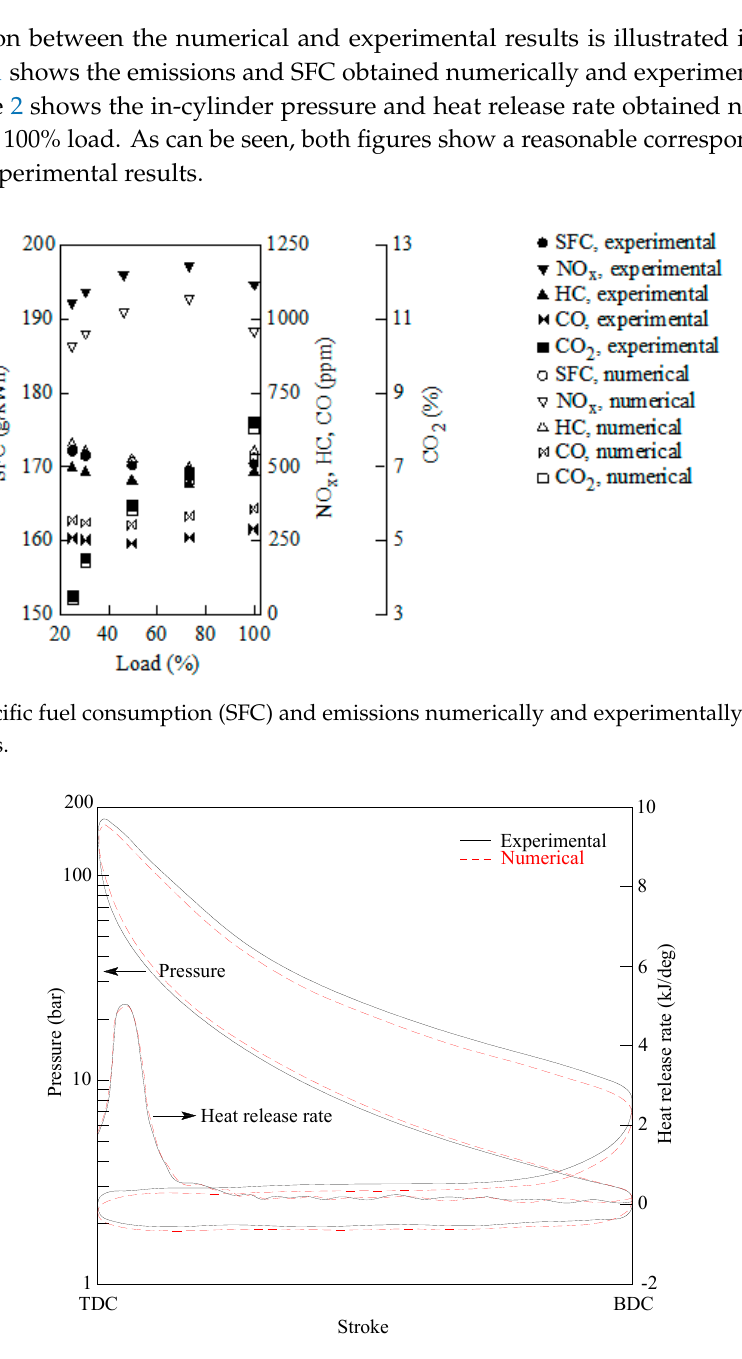
Figure 2. In-cylinder pressure numerically and experimentally obtained at 100% load.